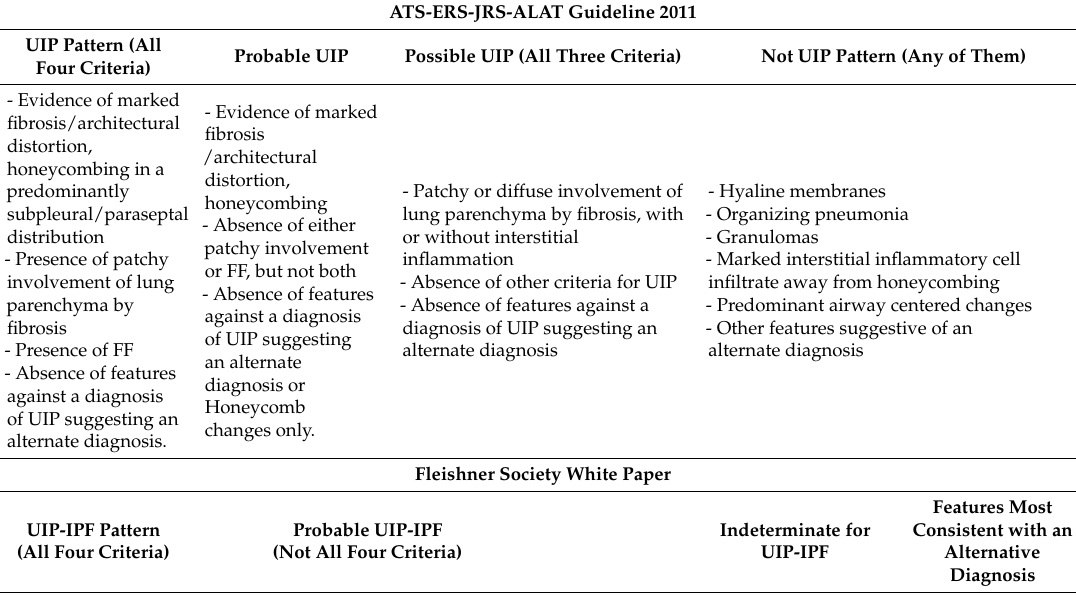
Table 1. Differences in Histologic criteria of UIP pattern between the American Thoracic Society (ATS), European Respiratory Society (ERS), Japanese Respiratory Society (JRS), and Latin American Thoracic Association (ALAT) guidelines 2011